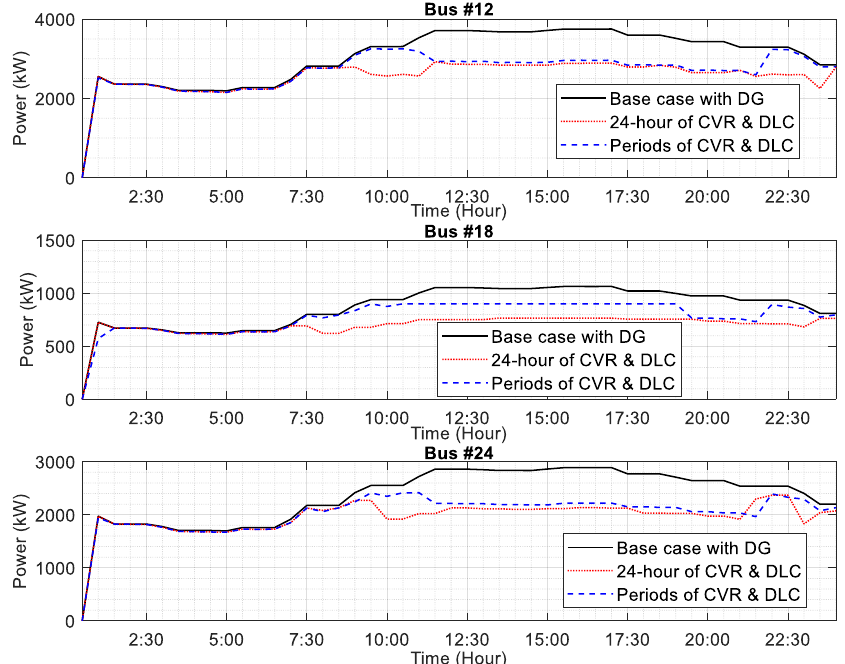
Figure 19. Case VIII: Power vs. time with/without CVR and DLC in the presence of DG.